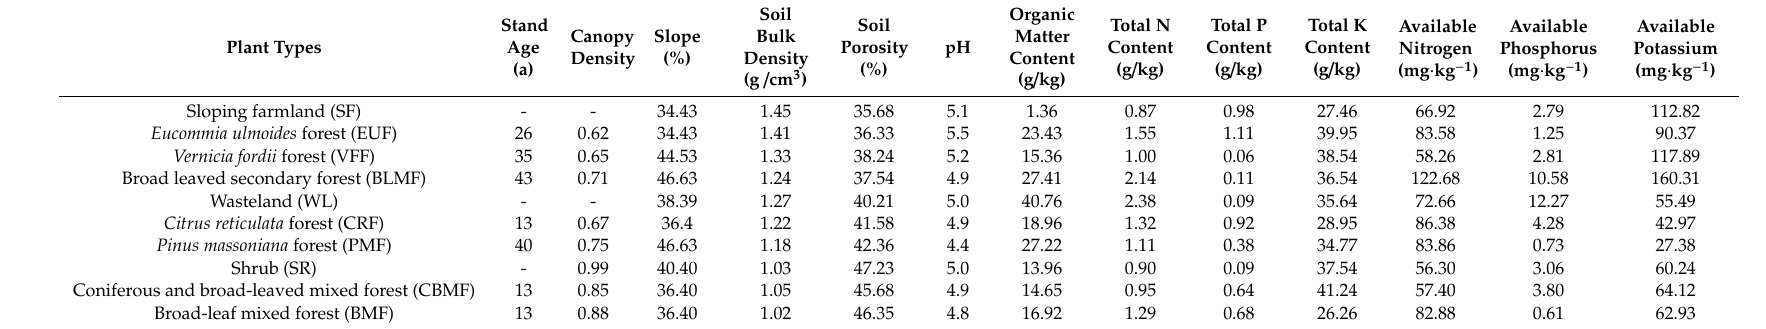
Table 1. Overview of di ff erent vegetation types in Nverzhai small